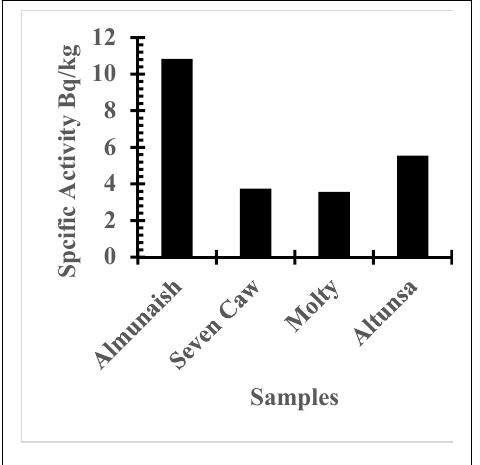
Fig. 1: The specific activity for 238 U in all samples.